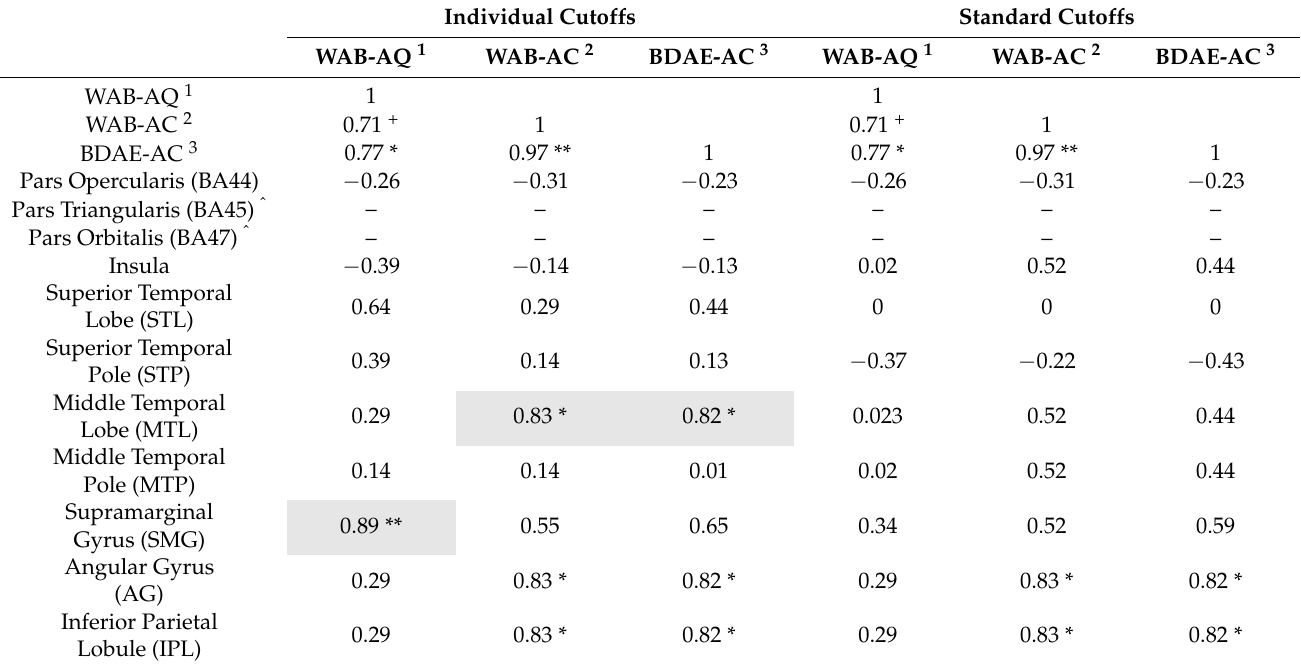
Table 5. A comparison of significant correlations between frontal, parietal and temporal ROIs and language measures using individual versus standard (<20 mL/100 g of tissue/min) hypoperfusion metrics. Gray shading represents significant correlations using the individualized approach not apparent with standard cutoffs. 1 WAB-AQ: Western Aphasia Battery- Aphasia Quotient; 2 WAB-AC: auditory comprehension composite (AC) score; 3 BDAE-AC: auditory comprehension (AC) composite score; * p < 0.05; ** p < 0.01; + p < 0.06; ˆ no hypoperfusion found for any of the